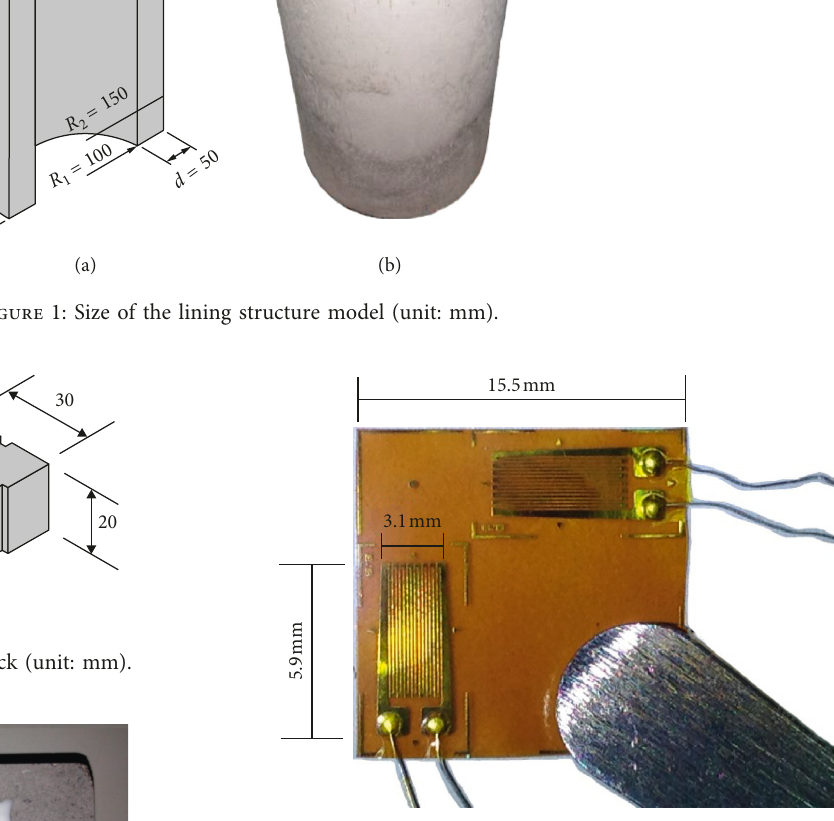
Figure 4: Strain gauge and sensitivity